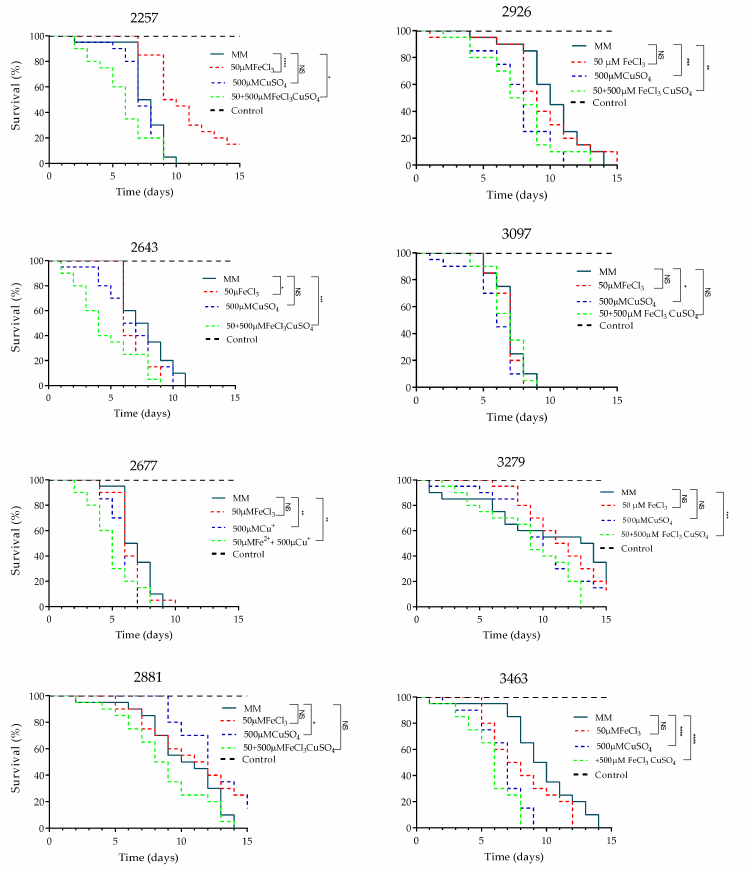
Figure 8. Effect of iron, copper, and their combination on the pathogenicity of eight additional clinical isolates of C. neoformans var. grubii ; p ≤ 0.05 (*); p ≤ 0.01 (**); p ≤ 0.001 (***); p > 0.0001